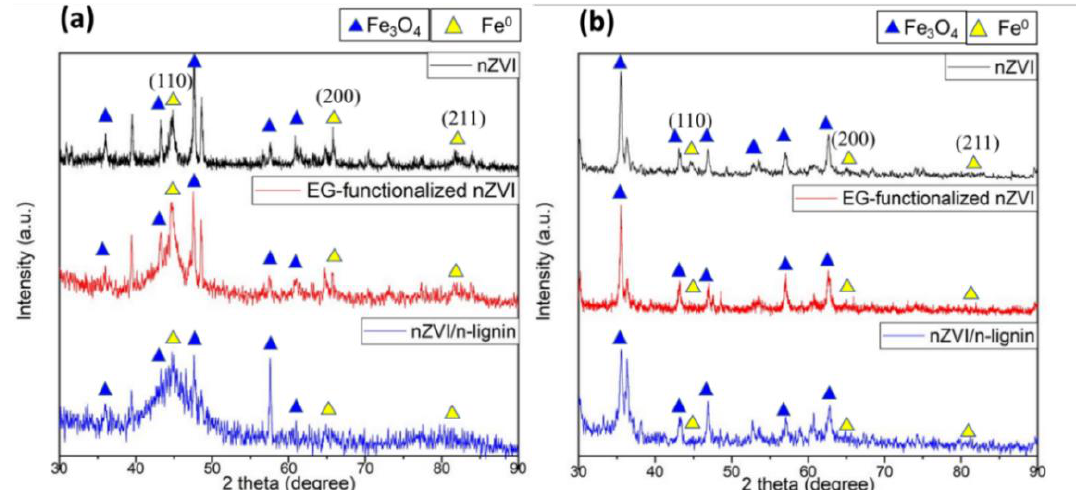
Figure 7. XRD analysis of aged bare nZVI, EG-functionalized nZVI, and nZVI/n-lignin: ( a ) exposed to air for 7 days and ( b ) put in water for 7 days.